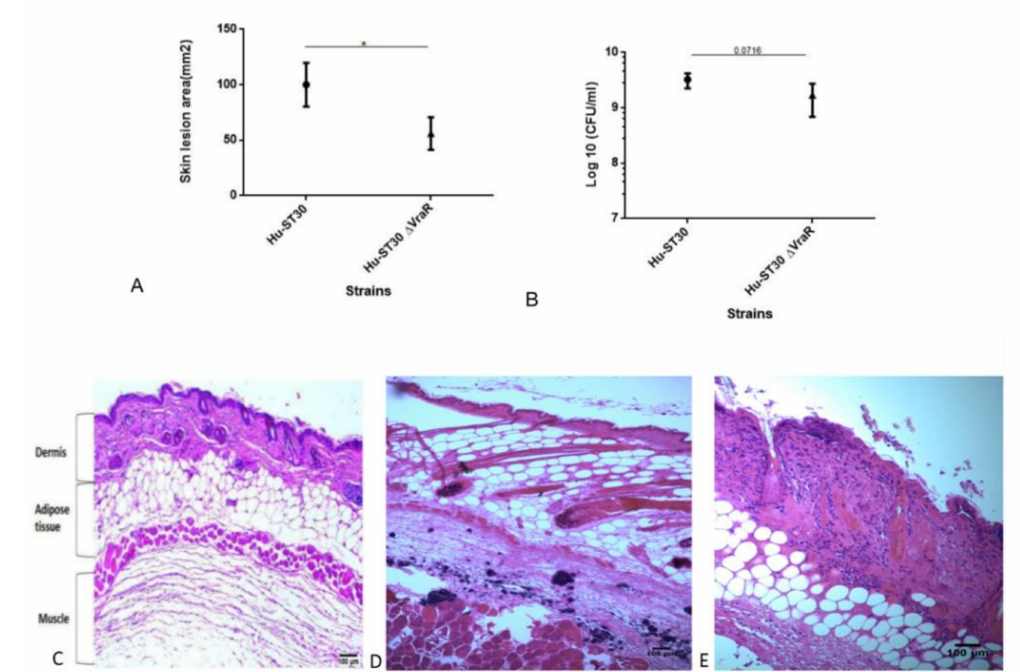
Figure 6. Deletion of VraR in MRSA ST30 strain showed reduced bacterial virulence. ( A ) Mice infected with wildtype ST30 or ST30 ∆ vraR . The skin lesion sizes were defined by darkened areas of necrosis and calculated by V = Π x (L × W)/2, V is the size of the lesion, L is the length of the lesion, and W is the width of the lesion. Hu depicts humanized mice. ( B ) Bacteria burden of mice after infection. The error bars represent the standard deviation of the mean values; significance was determined by one-way ANOVA, and coded as * p < 0.05. ( C , D ) Haematoxylin and eosin staining of the MRSA skin and soft-tissue infection mouse model. Mice were inoculated subcutaneously with either PBS or MRSA as described in Methods. ( C ) PBS control, ( D ) ST30 infected, and ( E ) ST30 (cid:52) vraR infected. Original magnifications of images are 100 ×